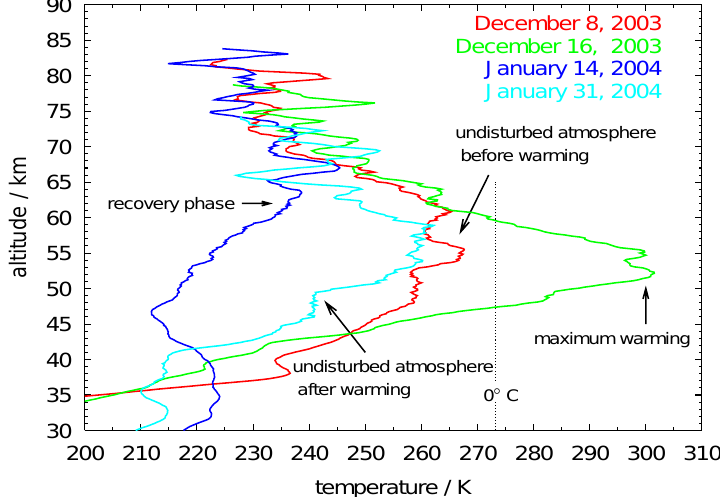
Fig. 9. Development of a stratospheric warming above the Esrange. The different stages of the warming were observed by the U. Bonn lidar during winter 2003/2004.